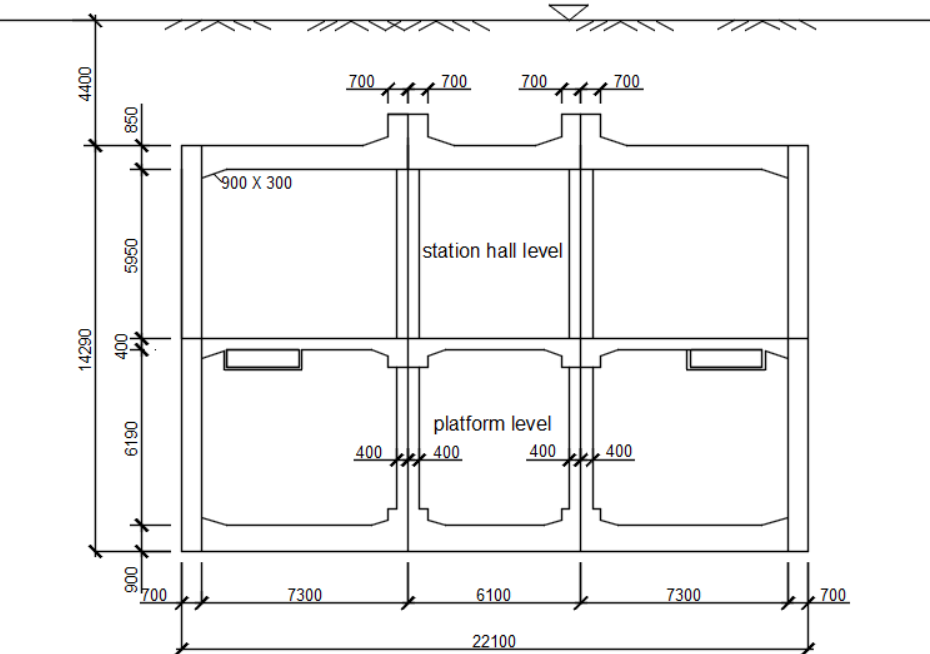
Figure 1. Cross-sectional view (vertical cut through the structure, normal to the axis of the tunnel) of a three-span two-floor reinforced concrete frame, providing the inspiration for fire testing in